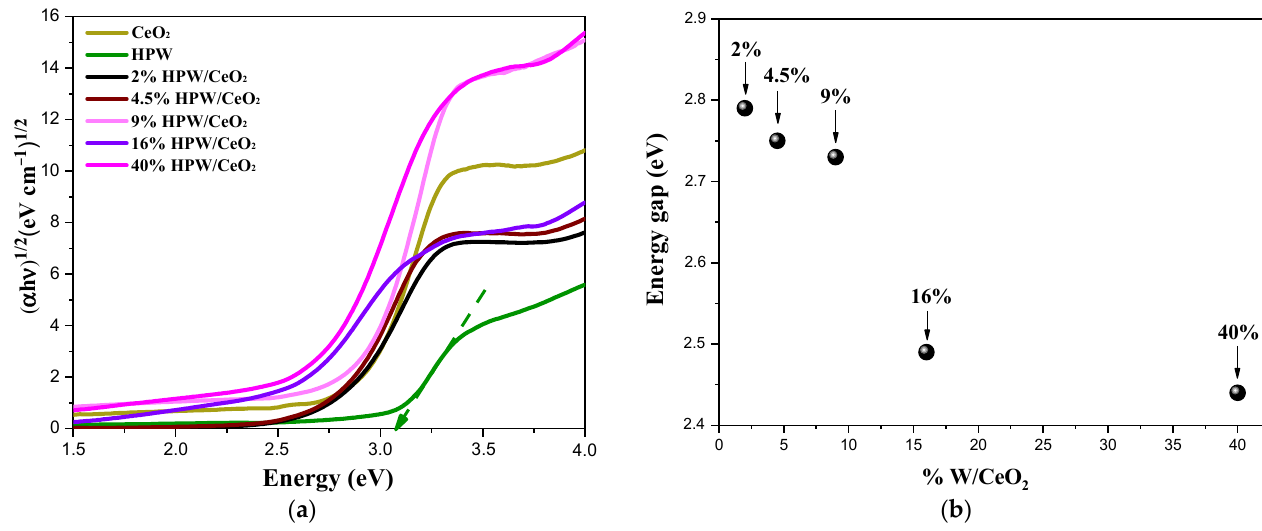
Figure 4. Tauc plots ( a ); the energy gaps (Eg) as function of W loadings for HPW/CeO 2 (2, 4.5, 9, 16, and 40 wt% W) ( b ). The characterization studies carried out for the different catalysts have shown that for low W loadings (2.5 and 4 wt% W), tungsten is mainly present on the ceria surface as monomeric species (Figure 5) while increasing the W loading also leads to oligomeric supported species and some WO 3 bulk. The estimated proportion of monomeric W species decreasing from 100% (2 wt% W) to 96 (4.5 wt% W), 64 (9 wt% W), 44 (16 wt% W), and 36% (40 wt% W).